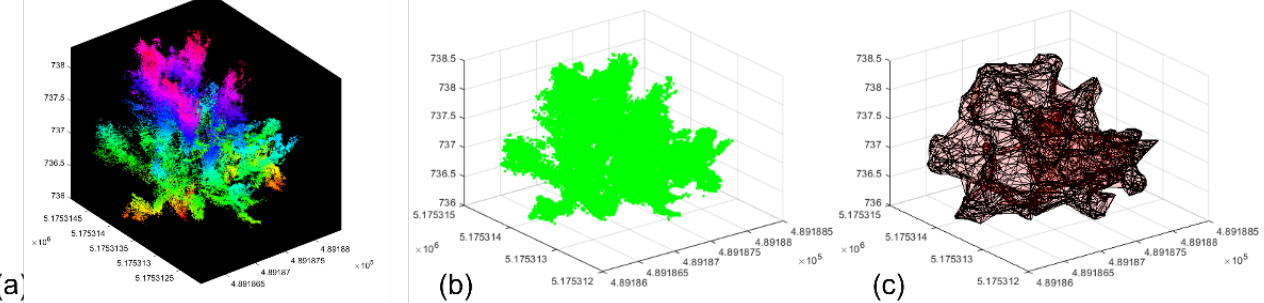
Figure 12. ( a , b ) Tree canopy crown delineation and ( c ) voxel grid model creating the boundary to measure the volume of the canopy crown.